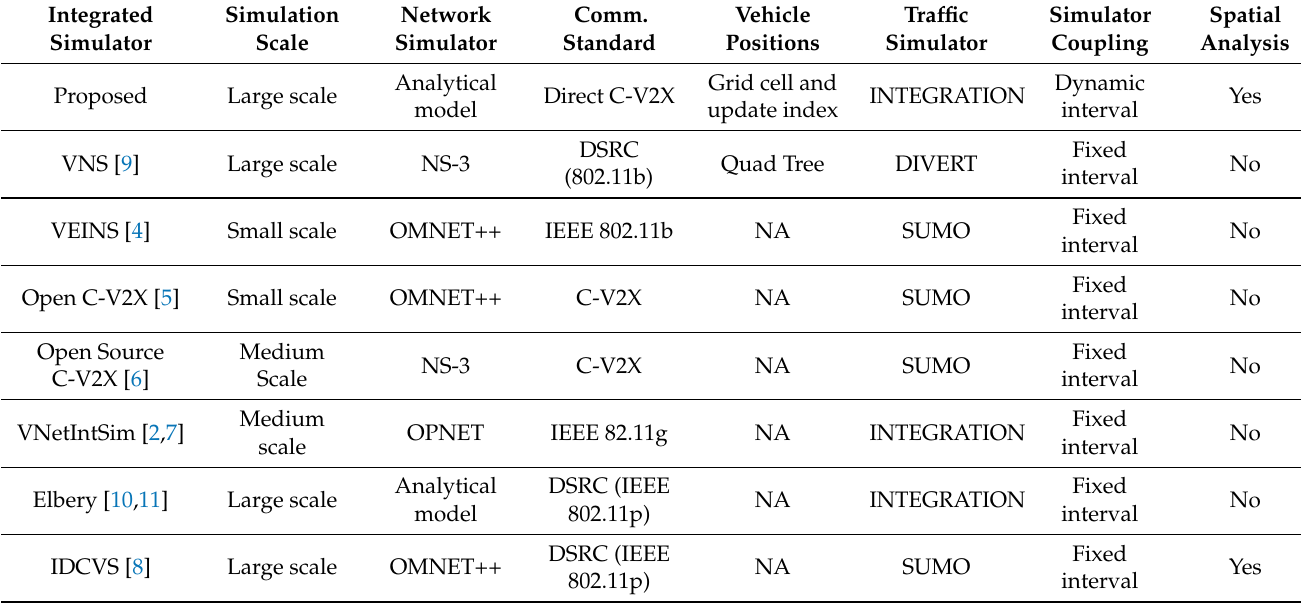
Table 1. Comparison of the proposed system against the Integrated Simulators in literature.